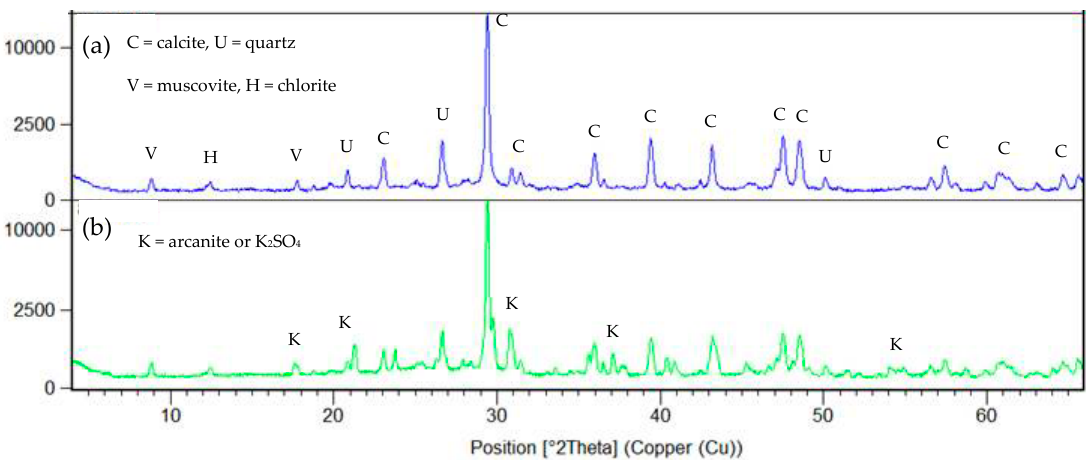
Figure 3. X-ray di ff raction patterns of cement raw meals. ( a ) As received. ( b ) Modified. Figure 3. X-ray diffraction patterns of cement raw meals. ( a ) As received. ( b ) Modified.